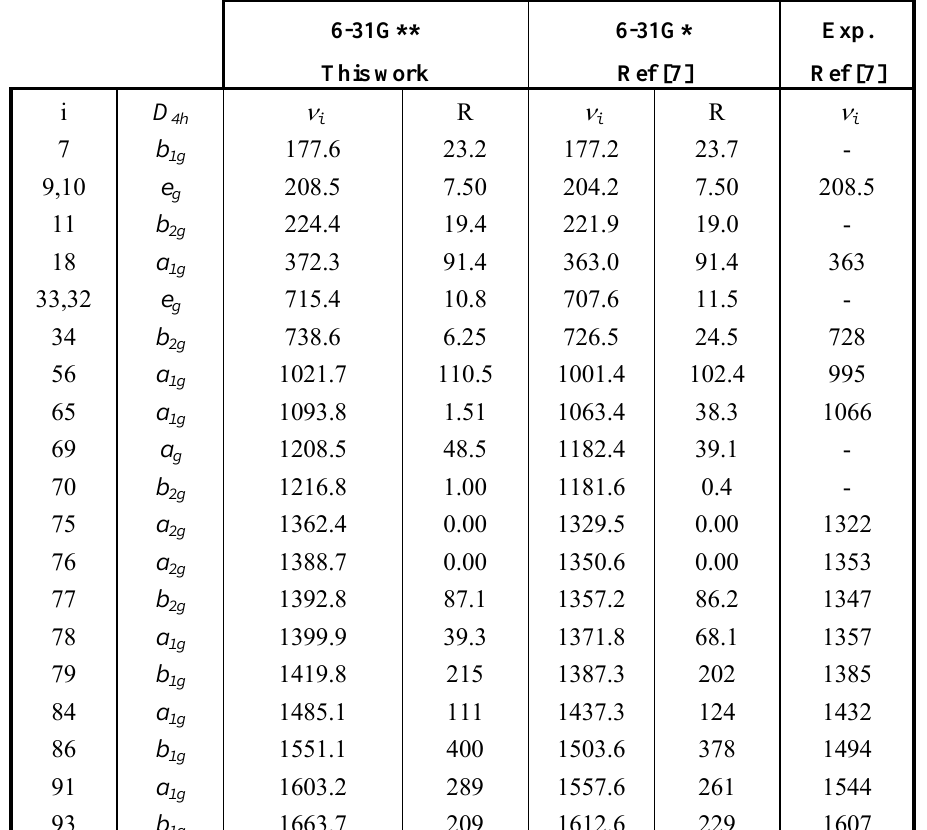
“ the wavenumber (cm -1 i